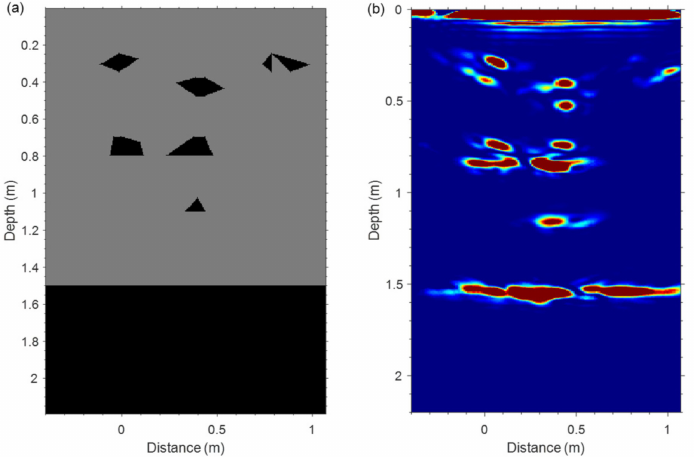
Figure 10. ( a ) Input scenario for FDTD model with an assumed boundary between regolith and bedrock at 1.5 m. ( b ) Imaging result of the FDTD model. Strong radar echoes can be found at the regolith/bedrock